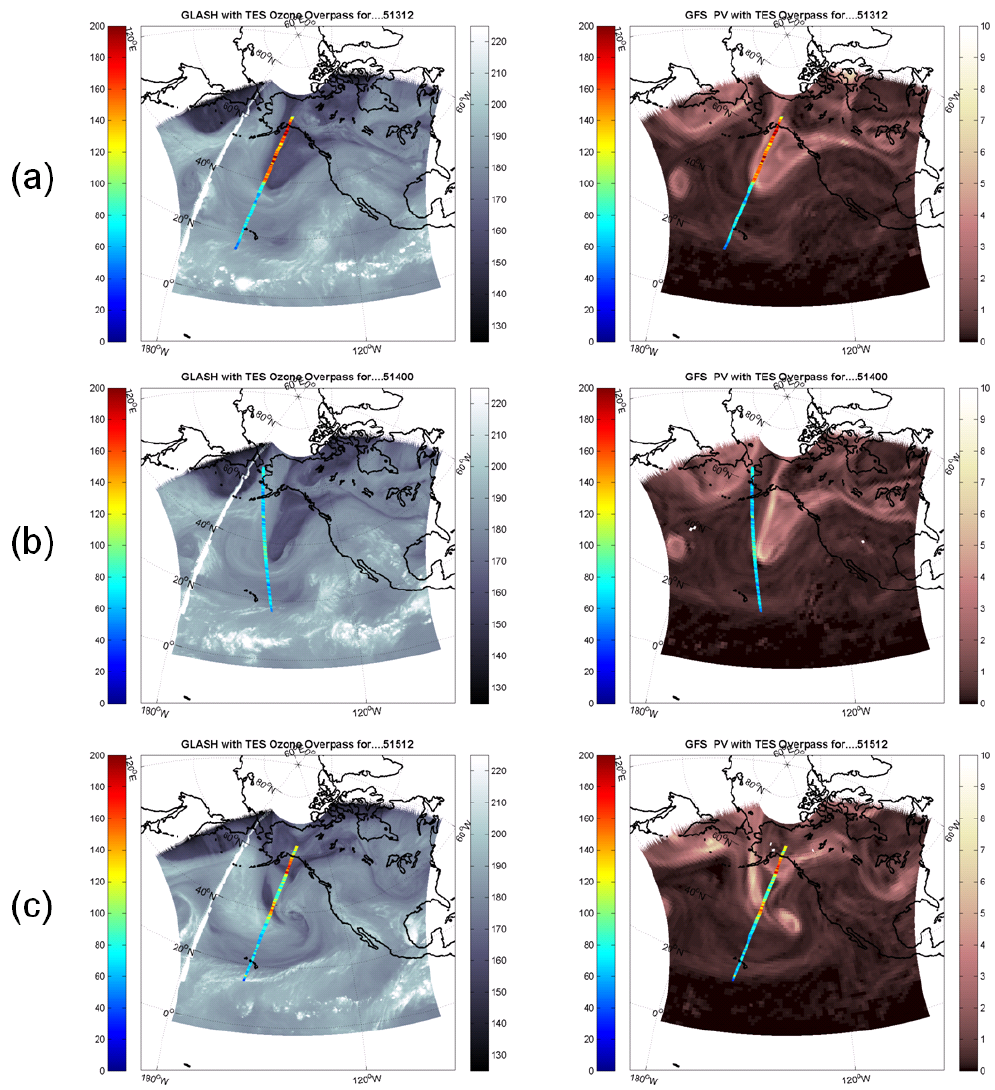
Fig. 3. This set of plots shows individual TES overpass layer-average UT ozone VMR (color shaded inppbv) plotted over fields of GLASH BV (grey shading) and GFS PV (pink shading in PV units) for three different times ( (a) 13 May at 12:00UTC, (b) 14 May at 00:00UTC, and (c) 15 May at 12:00UTC). Note the strong negative correlation between TES UT ozone and GLASH BV and the strong positive correlation between TES UT ozone and GFS